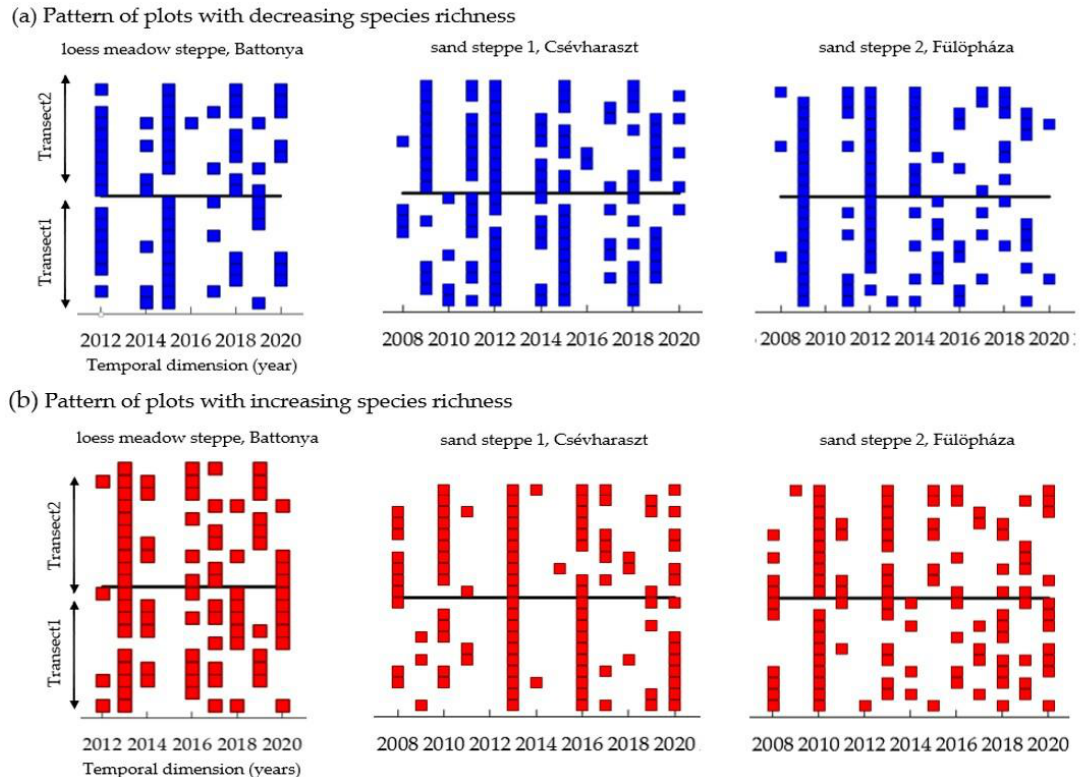
Figure 7. Spatiotemporal patterns of fine-scale diversity change between subsequent years at 2 m scale. ( a ) Blue squares mark the plots where local species richness decreased from the previous years. ( b ) Red squares mark the plots where local species richness increased from the previous